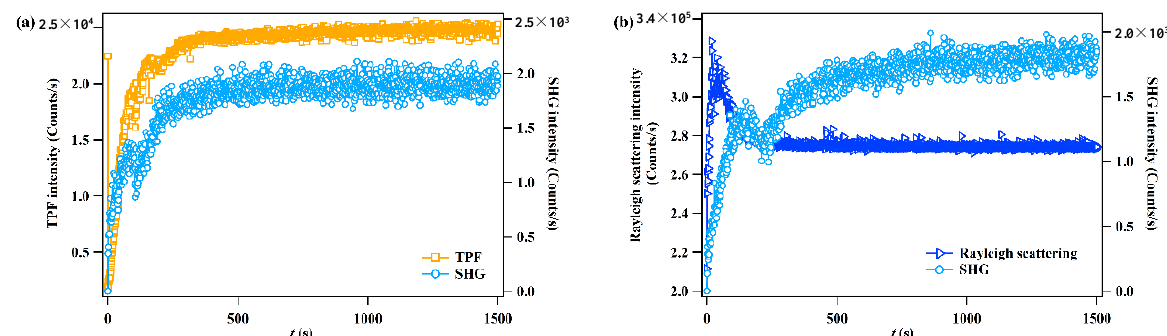
Figure 15. ( a ) Simultaneously detected TPF and SHG intensities after the addition of DOX solution to dried DOPG film with a final concentration ratio as 25/1000 µ M. ( b ) Simultaneously detected curves of the Rayleigh scattering and SHG intensities after the addition of DOX solution. Reproduced with permission [47]. Copyright 2022 Royal Society of